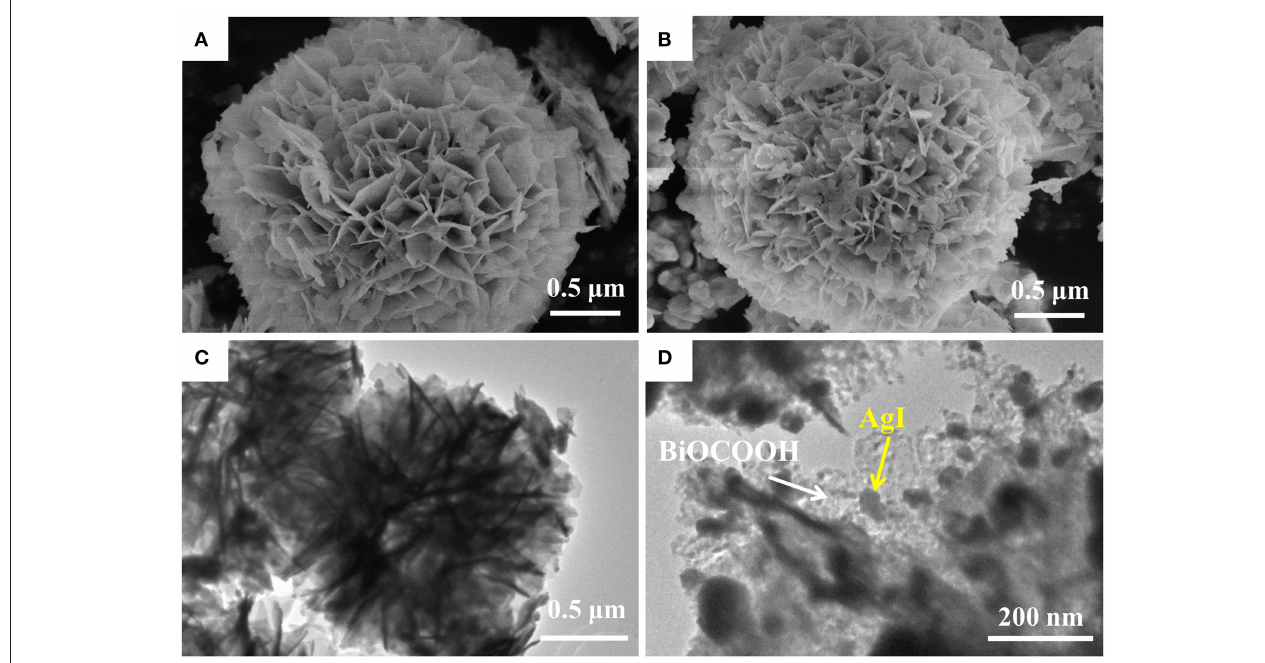
FIGURE 2 | SEM images of bare BiOCOOH (A) and S3 (B) ; TEM images of S3 (C,D) .